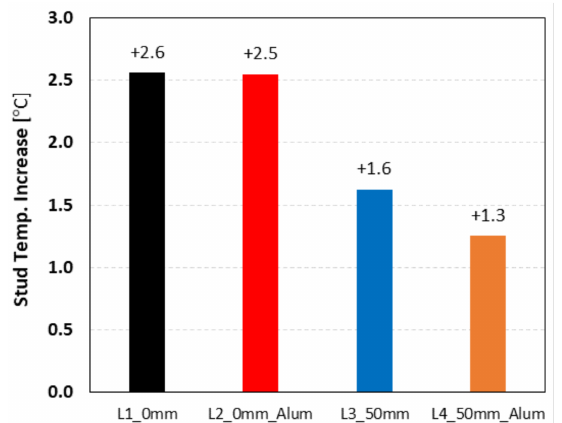
Figure 9. Steel stud surface temperature increase along horizontal lines on the cold surface of the double pane LSF walls, with and without reflective aluminium foil, for two air cavity’s thicknesses (0 and 50